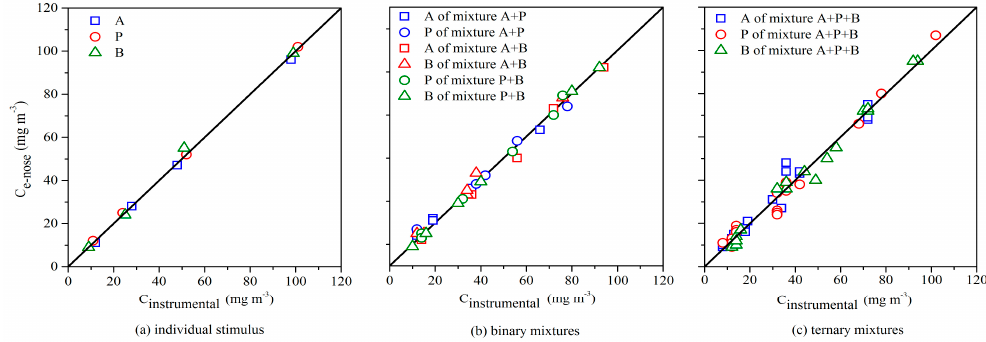
Figure 5. Comparison of measured chemical concentrations between the e-nose (C e-nose ) and the gas chromatography (C instrumental ). Odor samples consisted of acetaldehyde (A), propionaldehyde (P), and n -butyraldehyde (B).